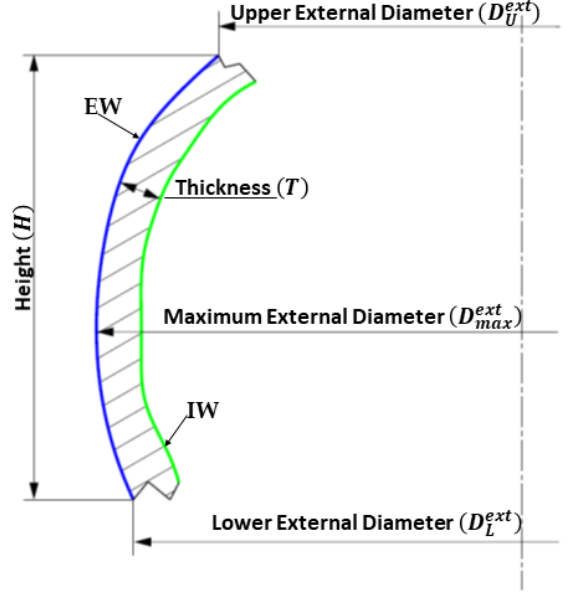
Figure 9. Main geometrical and dimensional features recognized in an archeological sherd.